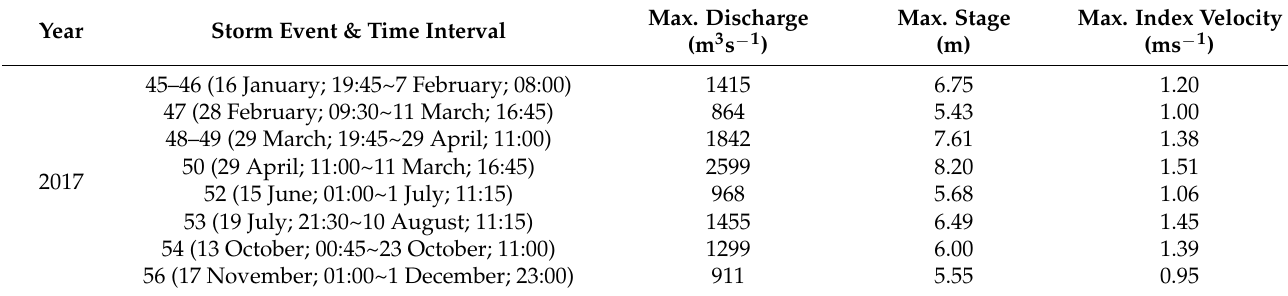
Table 2. Characteristics of the major storm events during the Water Year